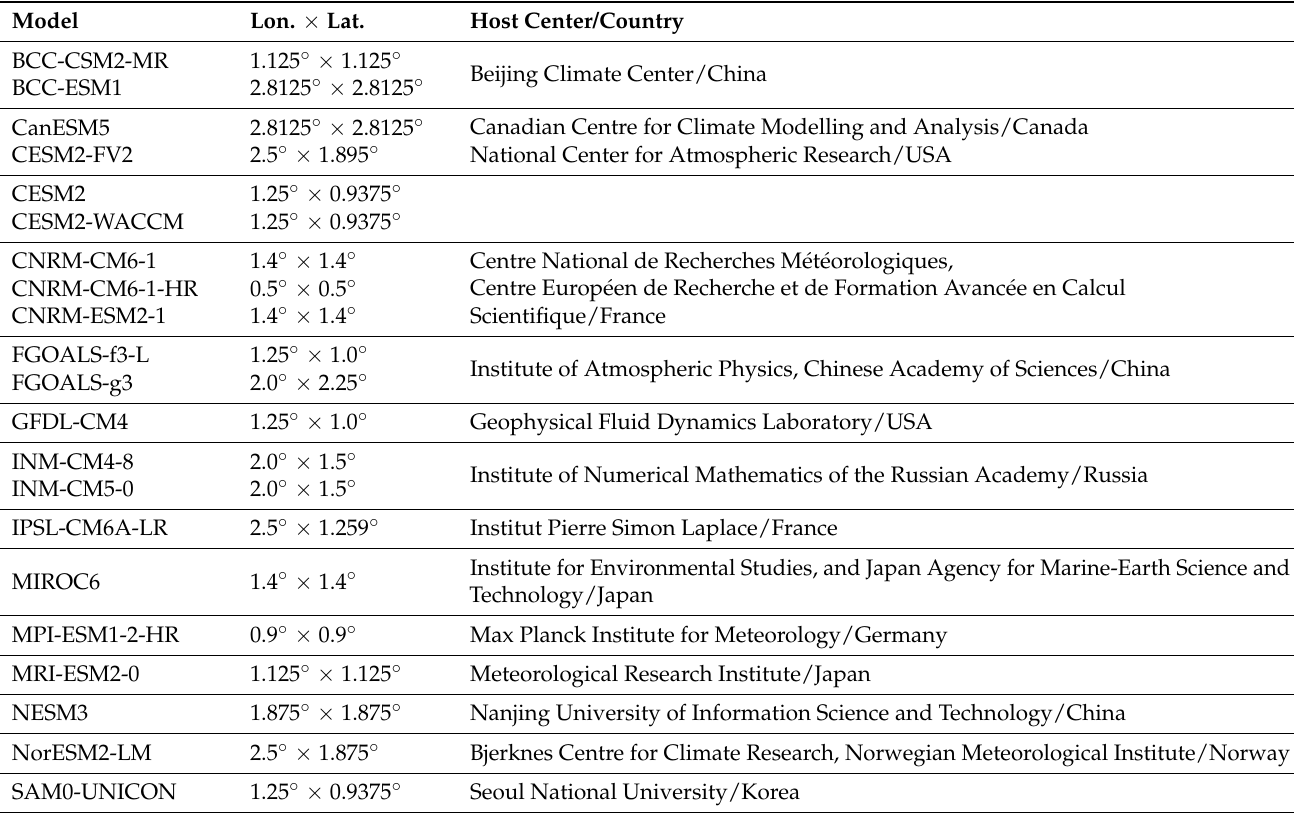
Table 1. Details of the 21 CMIP6 CGCMs used in this